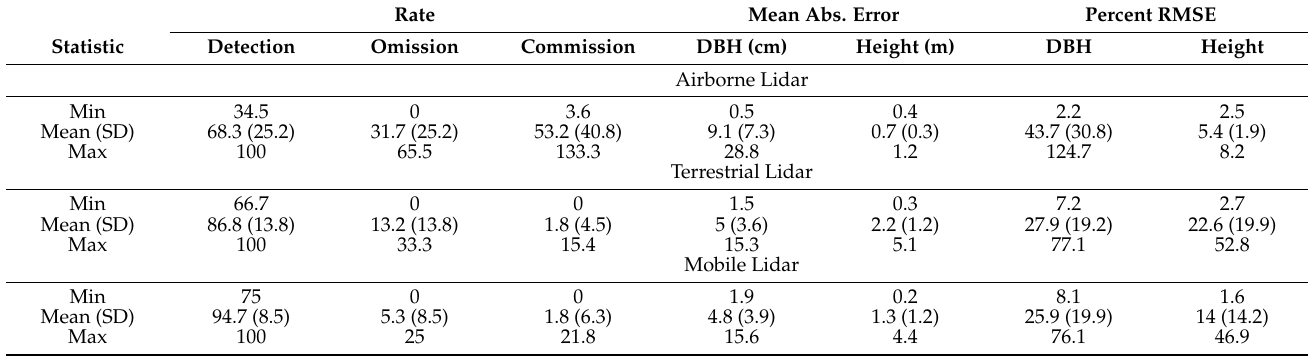
Figure 4. Distribution of platform-specific prediction errors among individual tree-level metrics ( a – c ) and plot-based metrics ( d – g ) for airborne (ALS), mobile (MLS) and terrestrial laser scanning (TLS). Significant Kruskal-Wallis rank sum test of the alternative that the location parameters of the distribution of prediction errors were different for each platform denoted by an asterisk and significant differences in pairwise tests for multiple comparisons of mean rank sums denoted using dots along the right y-axis. Table 2. Plot-level summary statistics for detection, commission and omission rates, as well as mean absolute error and percent RMSE for mean tree size (DBH and height) by lidar scanning platform. Rate Mean Abs. Error Percent